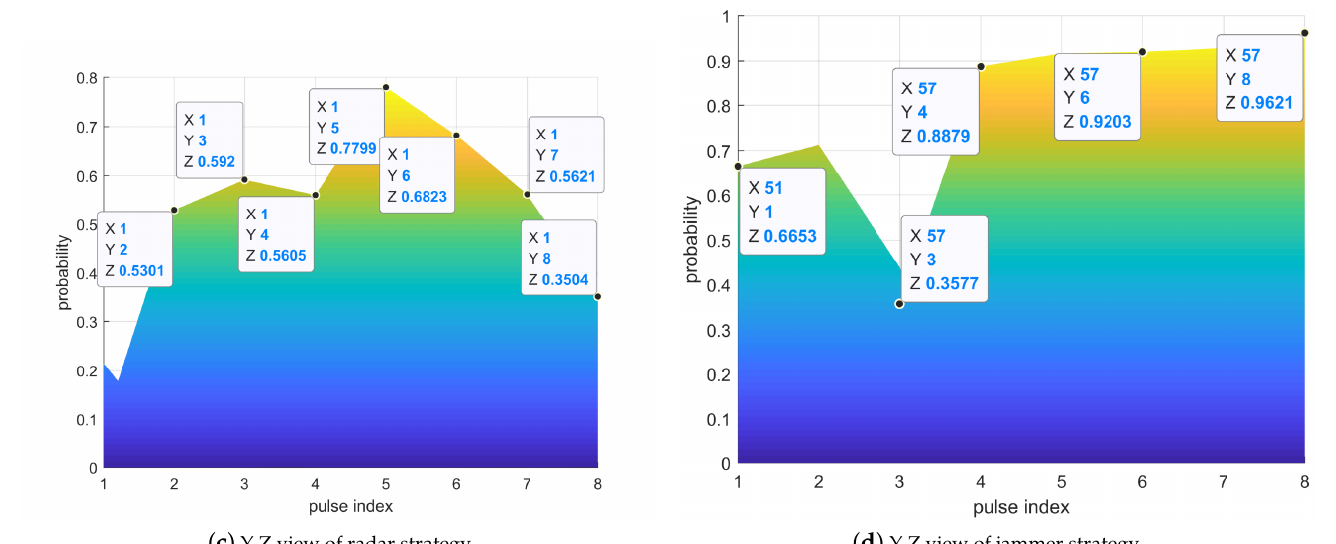
Figure 11. Approximate NE strategies with a quantization step of